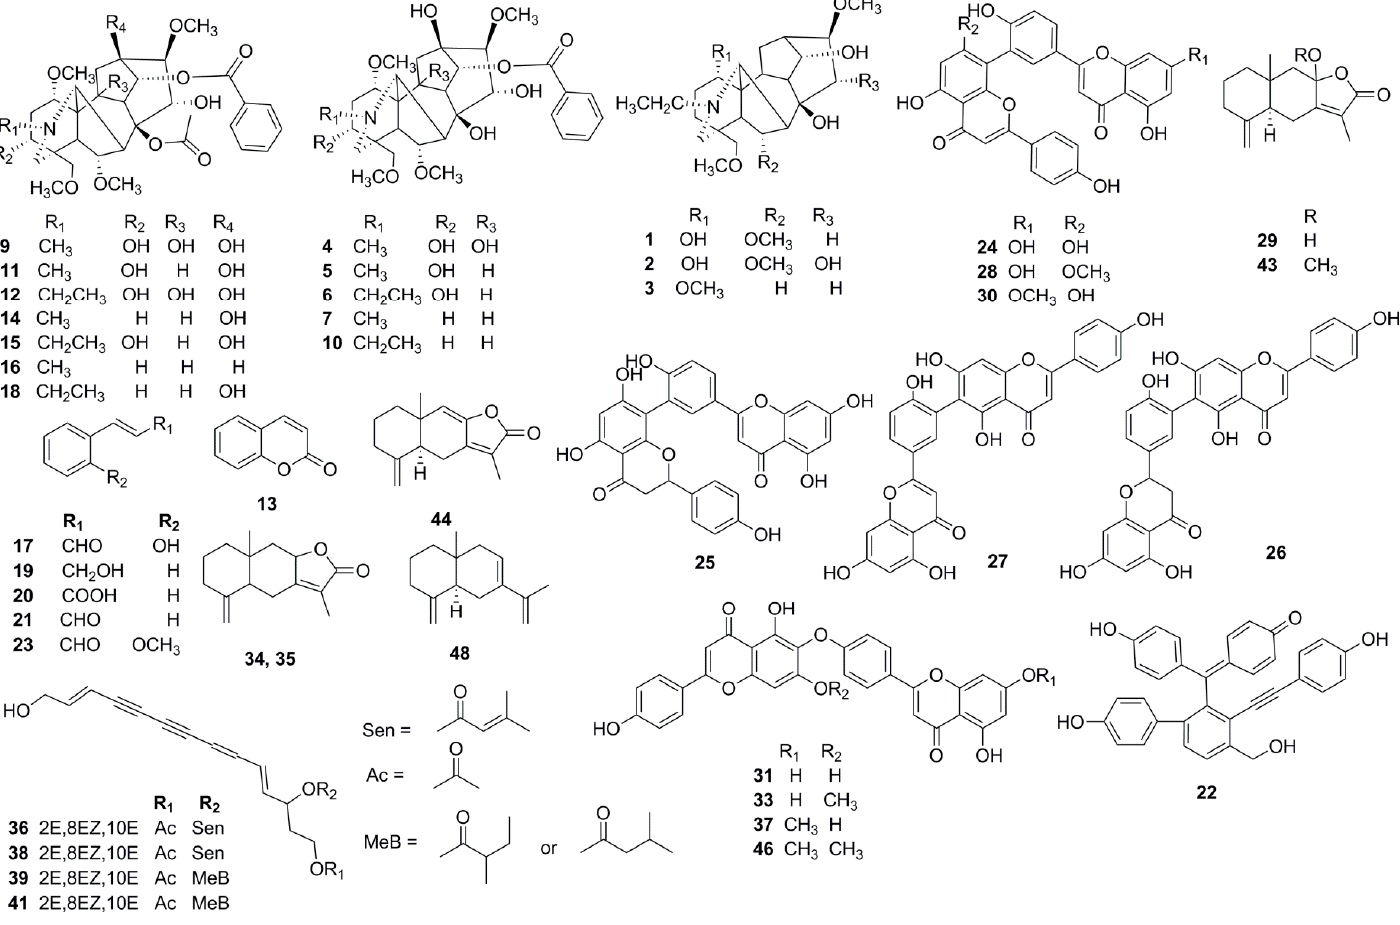
Figure 2. The chemical structures of compounds identified in WLY.